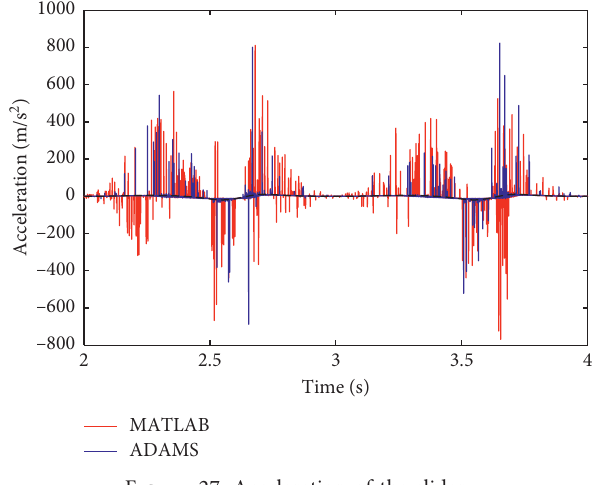
Figure 27: Acceleration of the slider.